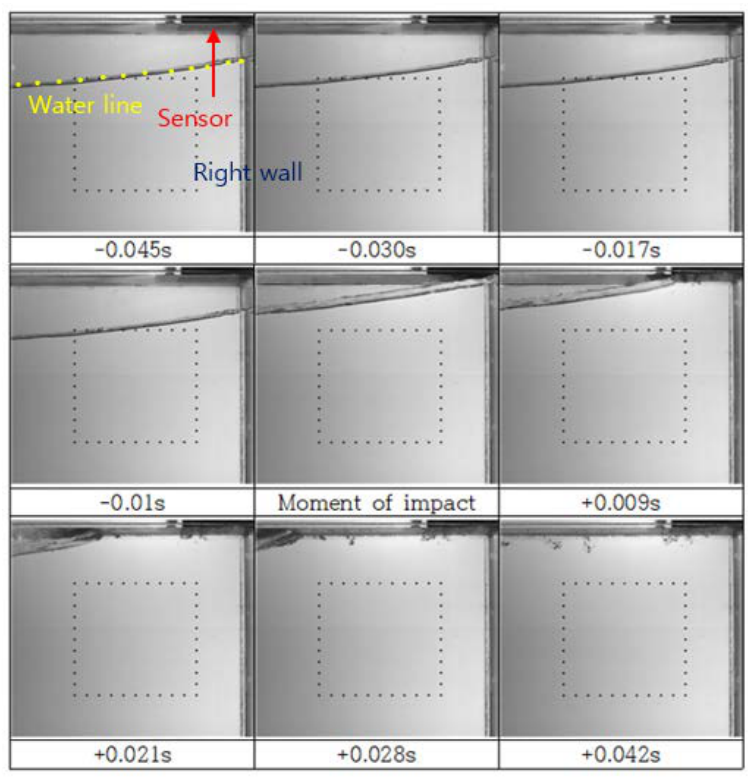
Figure 10. Snapshots of Flow: ROLL (Dry).